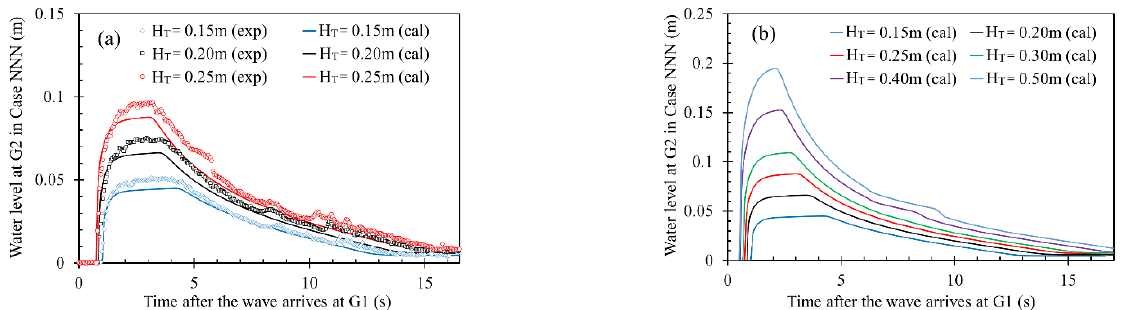
Figure 7. Time series of water level at G2 in Case NNN. ( a ) Comparison of simulated data with the simulation, ( b ) the simulated data with changing tank water depth in Figure 2.